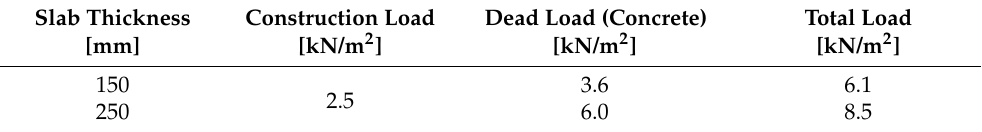
Table 2. Applied